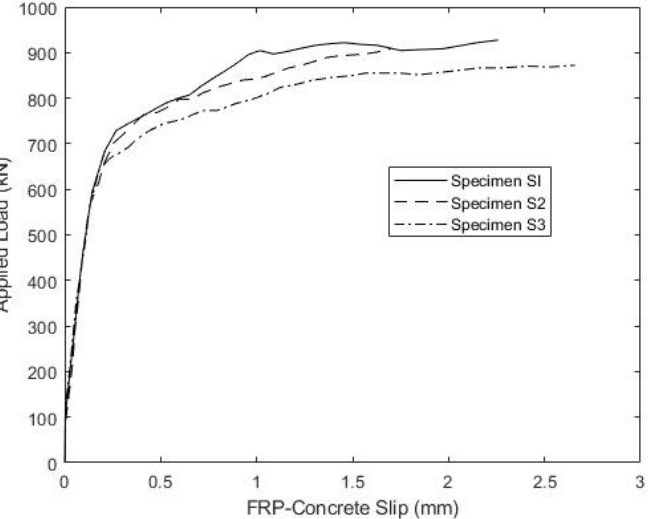
Figure 7. Shear Connection Load-Slip Response under Monotonic Loading to Failure.